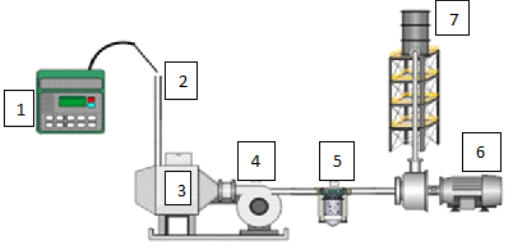
Fig. 2. Experimental setup. 1 – Flue gas analyser; 2 – Stack; 3 – Combustion chamber; 4 – Swirl oil burner; 5 – Oil filter; 6 – Oil pump; 7 – Oil